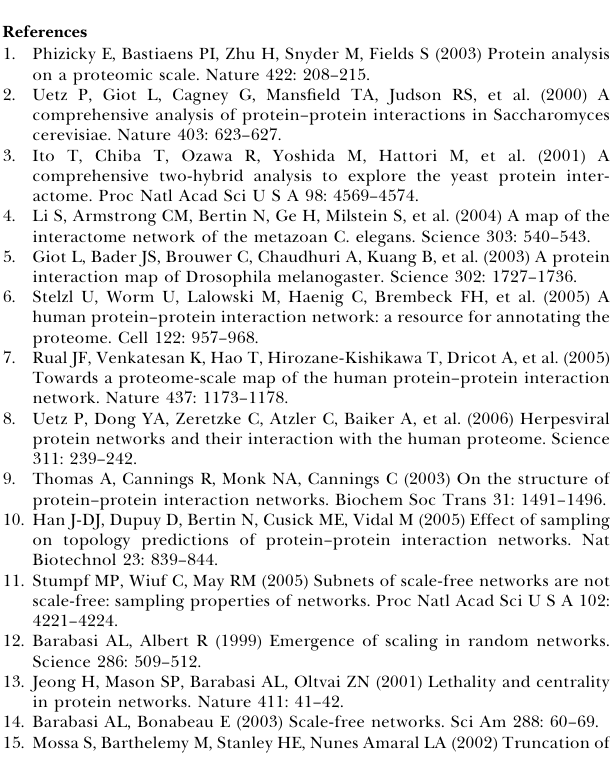
Table S3. Cellular Component Gene Ontology Terms Whose Baits Have a False-Discovery Rate Significantly Different from the Table S4. Biological Process Gene Ontology Terms Whose Baits Have a False-Discovery Rate Significantly Different from the Organism Table S5. Molecular Function Gene Ontology Terms Whose Baits Have a False-Discovery Rate Significantly Different from the Table S6. Estimates ˆk and ˆf Provided for Baits in Which Every Recovered Prey Was Unique Found at doi:10.1371/journal.pcbi.0030214.st006 (97 KB